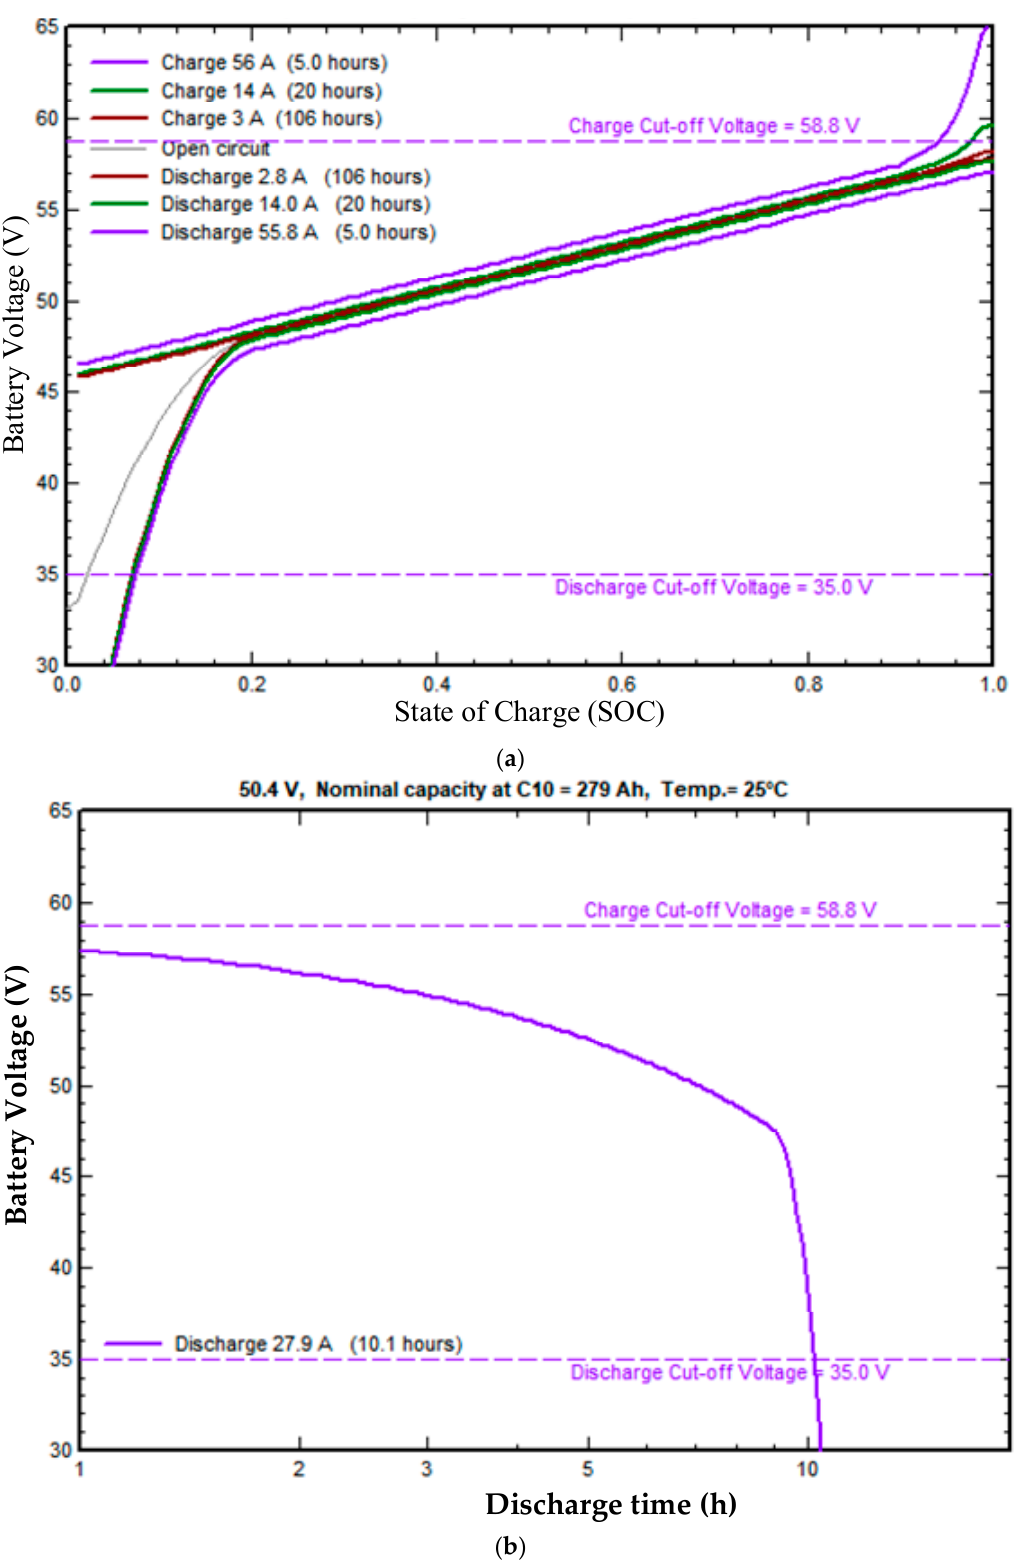
Figure 9. ( a ) Characteristics curve between charge / discharge vs. state of charge (SOC); ( b ) discharge characteristics curve.